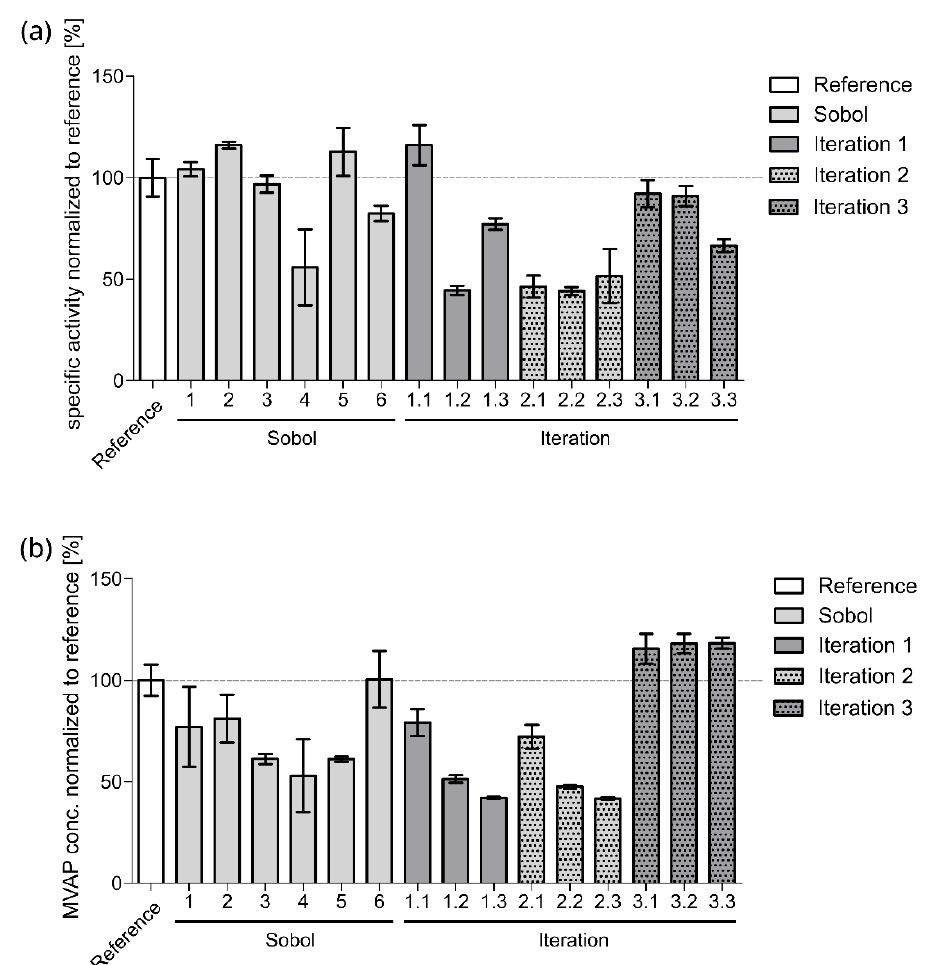
Figure 2. Results of the optimization approach with specific activities ( a ) and MVAP concentrations after 24 h ( b ) normalized to the reference assay. Enzyme assays were performed in triplicates with purified enzymes in 1.5 mL Eppendorf tubes. Enzyme assays contained 0.2 mg mL −1 of MVK, 50 mM of MVA, 55 mM of polyP, 3 mM of Na 3 VO 4 , 0.043 mM of NADP + , 0.43 mM of CoA, 170 mM of glucose, 200 mM of NaOAc, and 20 mM of MgCl 2 in 0.35 mL of the reaction volume, filled up with activity buffer (100 mM Tris-HCl, 150 mM NaCl, 10% glycerol, 20 mM MgCl 2 , pH 7.5). AMP, Aj PPK2, and Sm PPK2 were added in various concentrations, except in the reference assay where 55 mM of ATP was added. The reaction was incubated at 30 °C in a multirotator with 30 rpm. Samples were taken regularly, and enzymes were inactivated at 95 °C for 5 min.